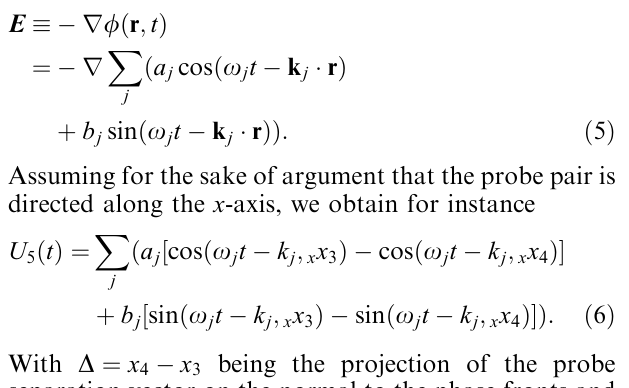
Fig. 3. Diagram of local drift vectors obtained from the ROSE F4 rocket data assuming a pure E (cid:2) B drift. The arrow with a circle gives the direction of the plasma drift as detected by EISCAT at the indicated altitude. The length of that arrow corresponds to a deduced DC electric field of 45 mV/m, for more details see the analysis of Rinnert (1992). Dashed lines indicate the magnetic field, dots the rocket trajectory. The magnetic field dip-angle is 77 (cid:14)